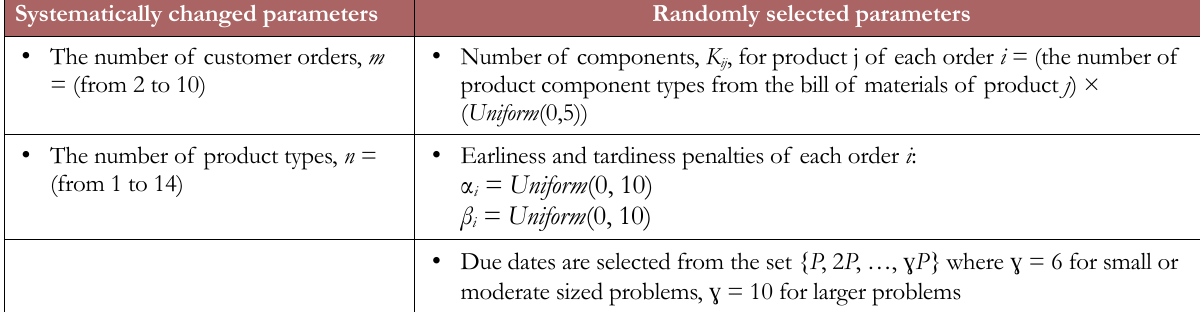
Table 1. Parameter generation for the test